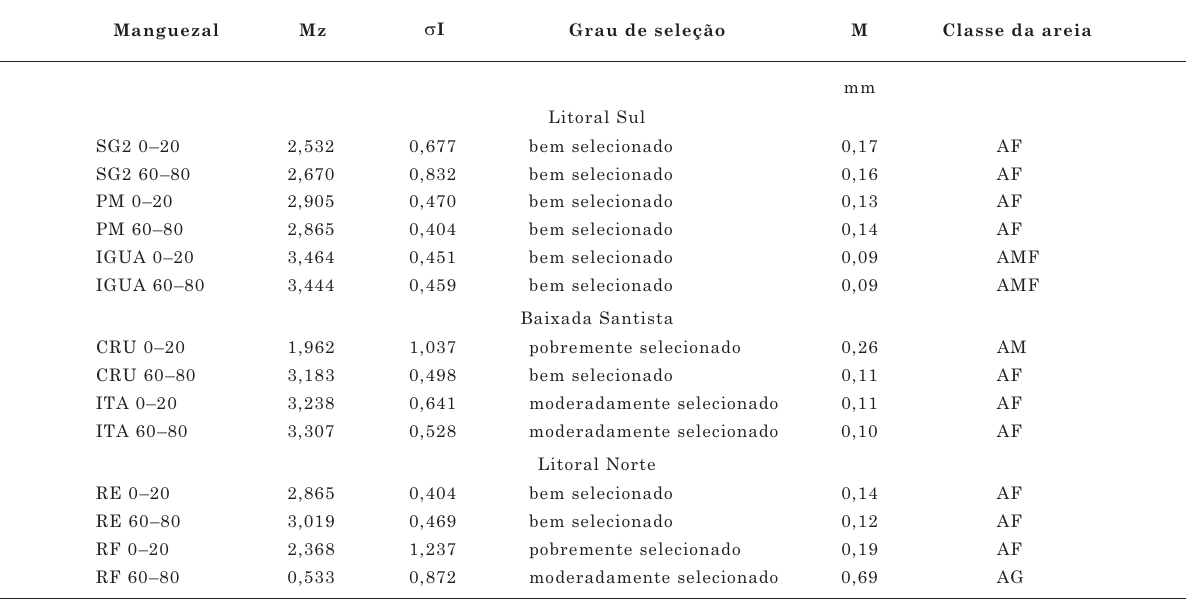
fração humina da matéria orgânica e por TL de grão de quartzo